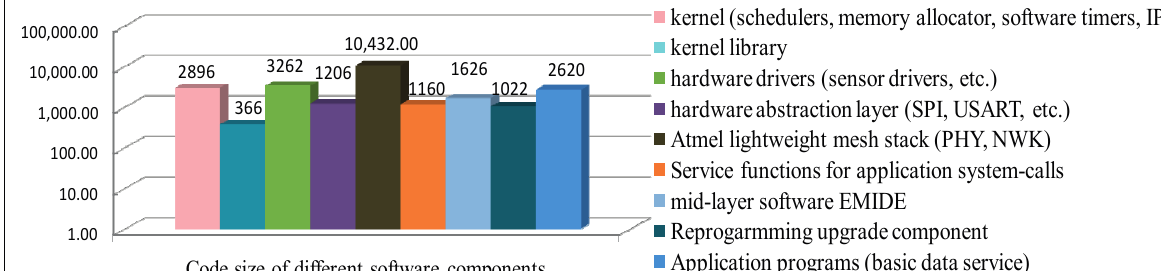
Figure 16. Code size of the different MIROS components on the iLive